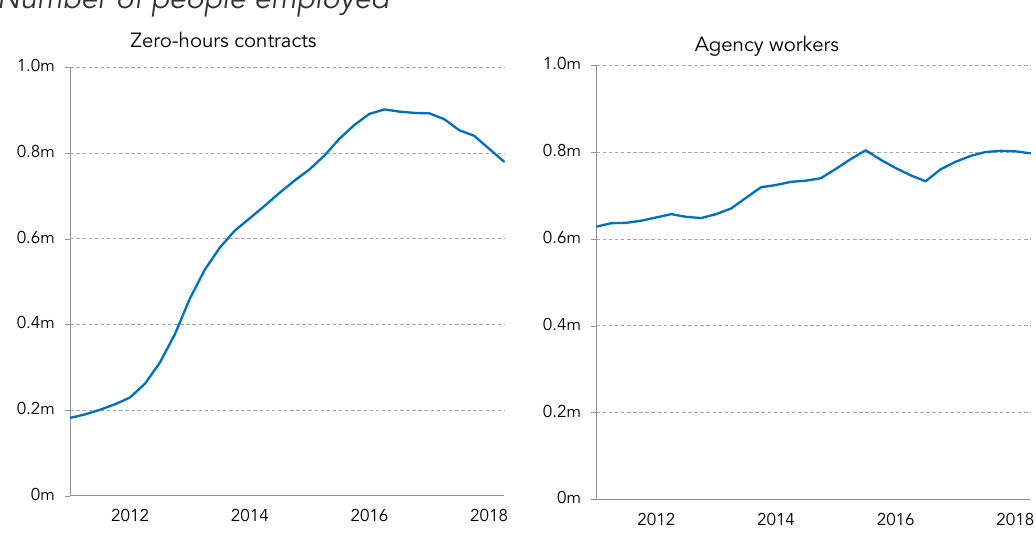
Figure 30: the growth of agency workers has stalled, and zero-hours contracts are falling Number of people